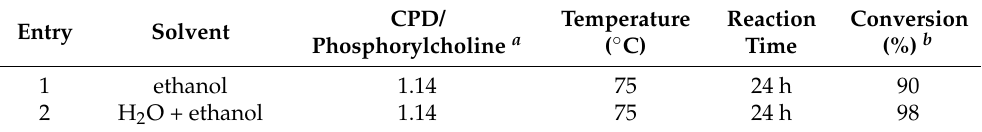
Table 3. Reaction conditions and conversions of second reaction steps in a batch reactor.